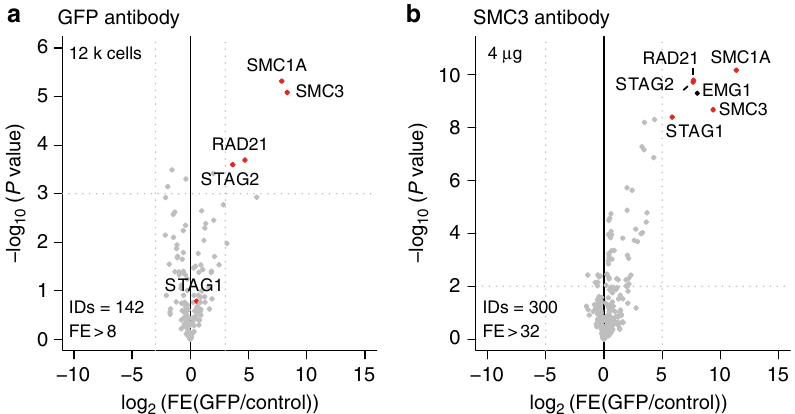
Fig. 4 On-chip AP-MS using antibodies. a , b Volcano plot of SMC1A-GFP enriched using a GFP antibody ( a ) and an antibody against native SMC3 protein ( b ). ID refers to the total number of proteins reported and FE stands for fold enrichment. Dotted gray lines represent statistical cut-offs. Black dots identify signi fi cant proteins; red dots are used for known interactors of the bait. EMG1 is a known contaminant 33 . The volcano plot in panel a presents n = 1 biologically independent experiment, each comprised of n = 3 technical replicates for PI-GFP and control extract. The volcano plot in panel ( b ) presents n = 2 biological replicates, each comprised of n = 3 technical replicates for PI and control